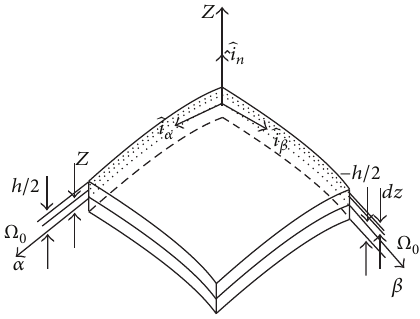
Figure 1: Notation and reference system for